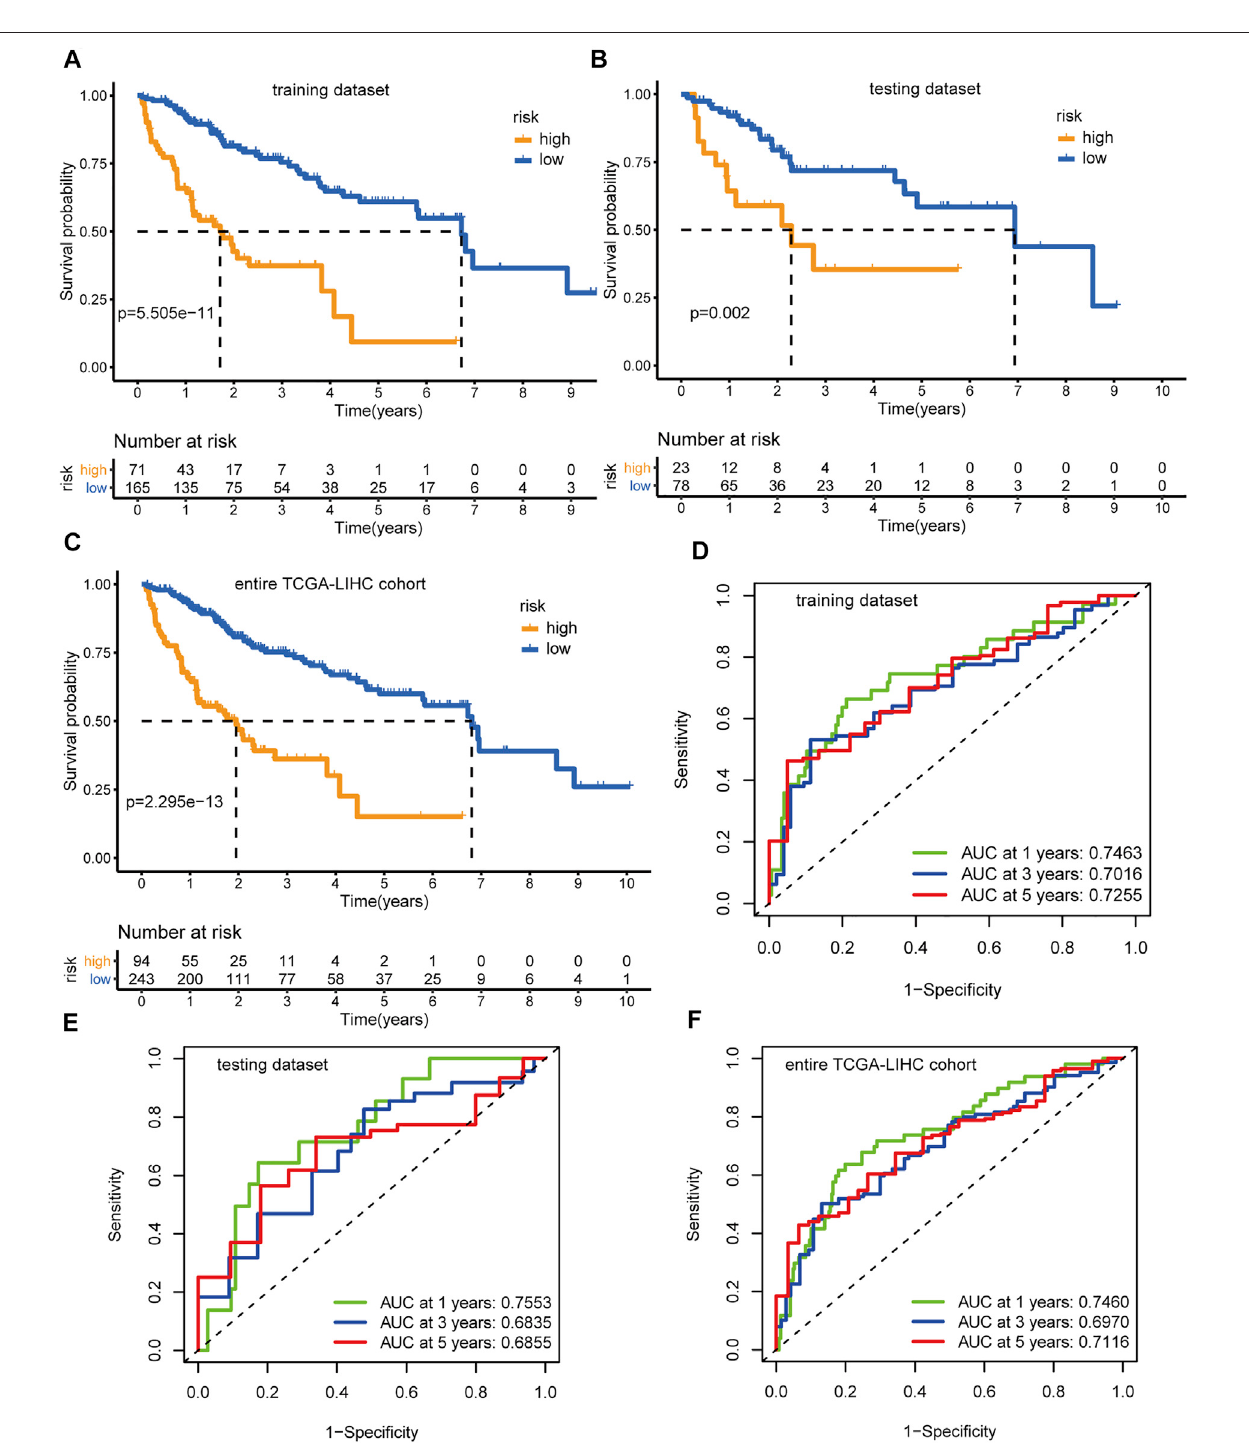
FIGURE5| Identi fi cationandvalidationofthehypoxia-relatedlncRNAs signature.Kaplan-Meier curvesandlog-ranktestp-valueofthetrainingdataset (A) ,testing dataset (B) , and entire TCGA-LIHC cohort (C) , respectively. The AUCs of the time-dependent ROC curves for the training dataset (D) , testing dataset (E) , and entire TCGA-LIHC cohort (F) , respectively.